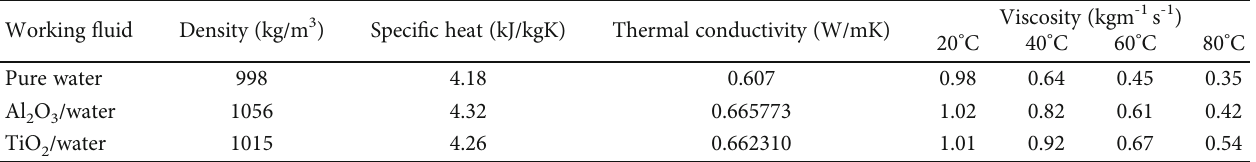
Table 3: Thermophysical properties of nano fl